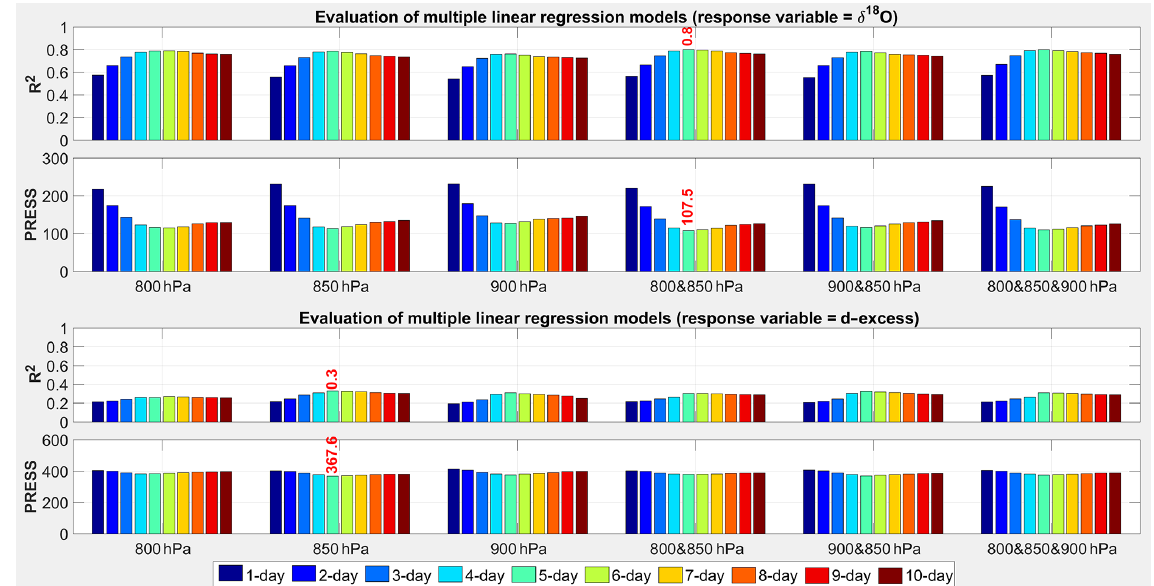
Figure 11. Evaluation of multiple linear regression (MLR) models applied for δ 18 O and d-excess as response variables for different pressure levels used for three HYSPLIT backward trajectories and their combinations (mean values of the different levels). The best MLR model is marked with red